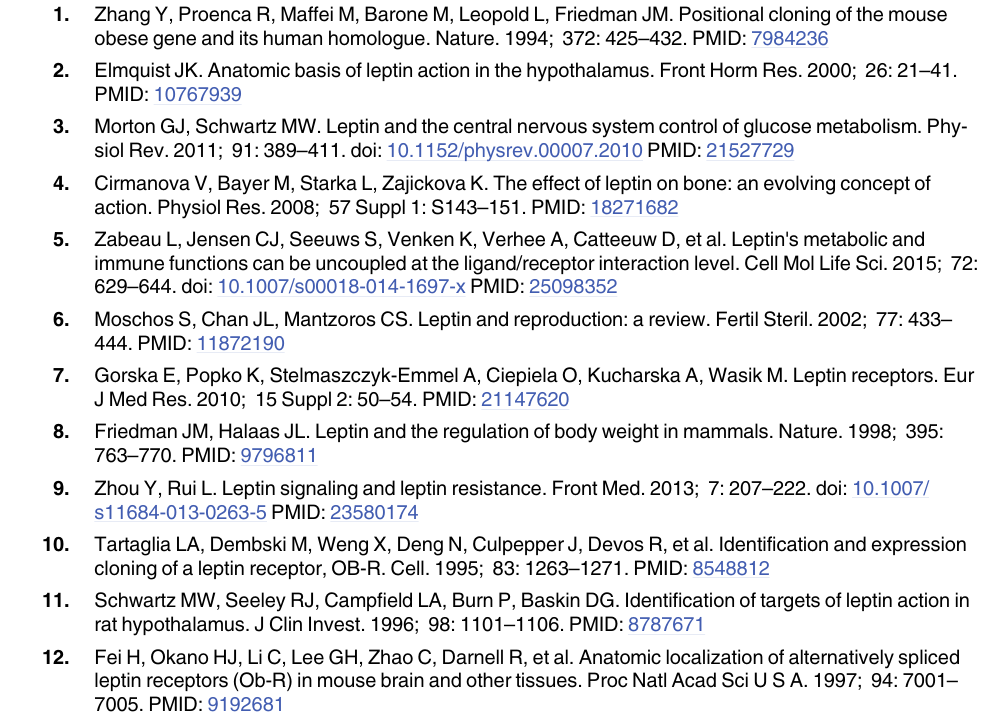
S1 Table. Gene expression differences between Y123F and WT by Illumina Microarrays. S1 Table gives gene lists with significant changes of mRNA levels in ovaries of the mouse strain (denoted Y123F) with artificially mutated leptin receptors, with phenylalanine (F) substitution for all 3 tyrosine (Y) residues within exon 18 of LepRb of Tyr985, Tyr1077 and Tyr1138, with wild types of the same litter as the control. Y123F mice also manifested obesity, hyperphagia, hyperleptinemia, hyperinsulinemia and impairment in glucose tolerance. Young mice sub- jected to cDNA microarray analysis, LepR/WT indicated the Y123F signal value/control signal value. Ovarian tissues of 12 weeks old Y123F and Control mice was taken from 6 ovaries of 6 mice respectively, and then mixed into RNA pools for the DNA microarray analysis by United Gene Technology Co Ltd (Shanghai). Mouse WG-6 v2.0 chip (microarray chips, Illumina) was used as the mouse whole genome expression profiling bead chip. The original data were uploaded into GEO library